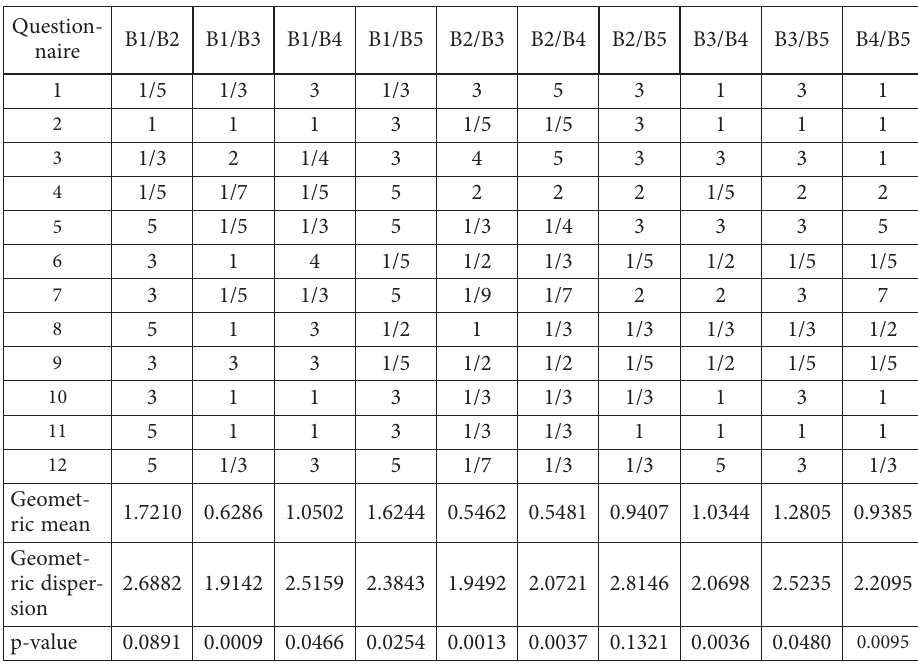
Table 10. Judgments, geometric means, and p -value of